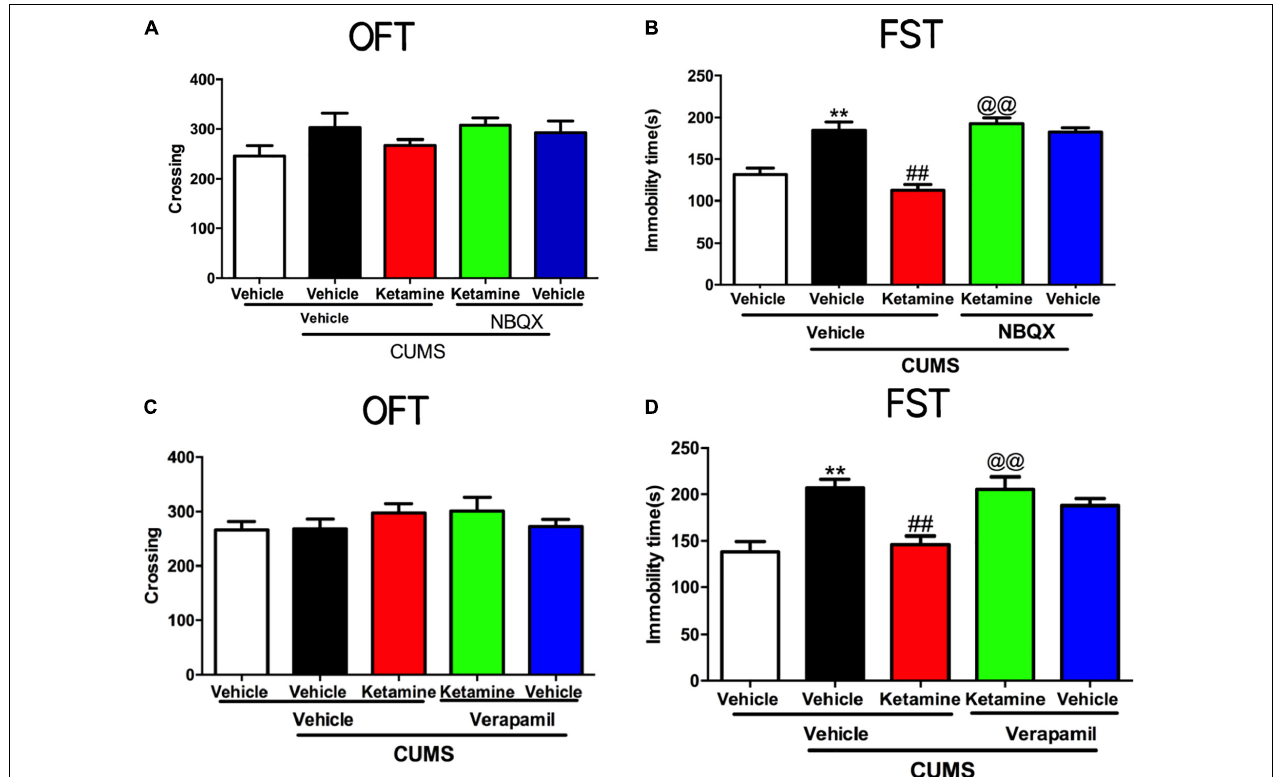
FIGURE 4 | The roles of AMPAR and L-VDCC played in the rapid antidepressant effect of Ketamine. The crossing of mice in an open field test in AMPAR blocked (A) and L-VDCC inhibition (C) ; the immobility time of mice in forced swimming test in AMPAR blocked (B) and L-VDCC inhibition (D) . The data are expressed as means ± SEM, n = 10. ∗∗ P < 0.01 compared with vehicle + vehicle + non-stressed group; ## P < 0.01 compared with vehicle + vehicle + CUMS group; @@ P < 0.01 compared with ketamine + vehicle + CUMS group.